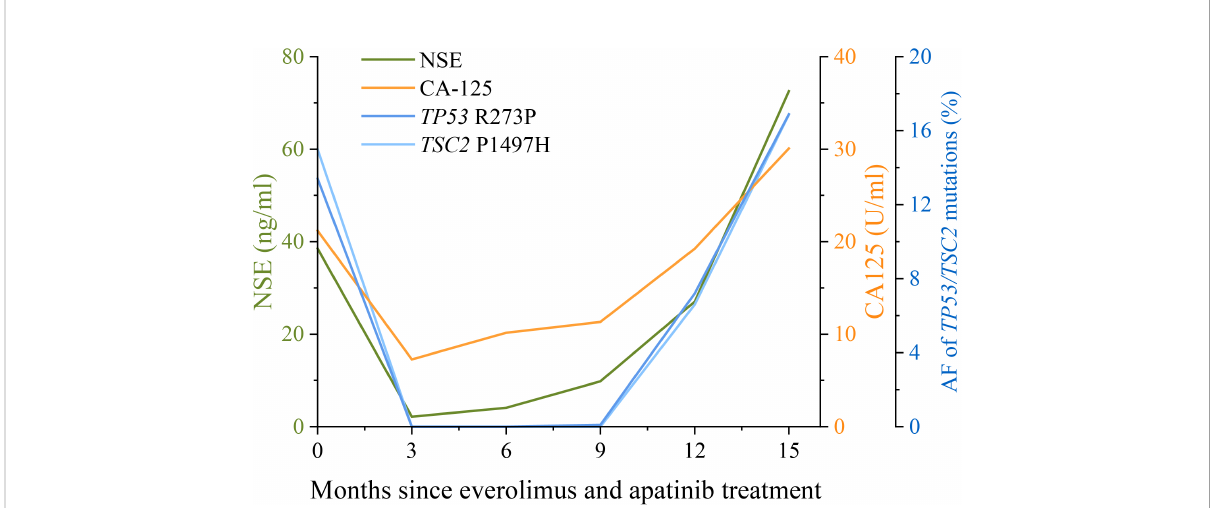
FIGURE 2 Changes in NSE and CA125 levels, and the allele frequencies (AFs) of TP53 and TSC2 mutations during apatinib and everolimus treatment. The levels of the lung cancer biomarkers NSE (neuron-speci fi c enolase) and CA125 (cancer antigen 125) in serum examined every 3 months are shown by the green and orange lines, respectively. Plasma ctDNA sequencing was also performed every 3 months during apatinib and everolimus treatment. The AFs of TP53 R273P (blue) and TSC2 P1497H (light blue) mutations are shown by the dark blue and light blue lines,